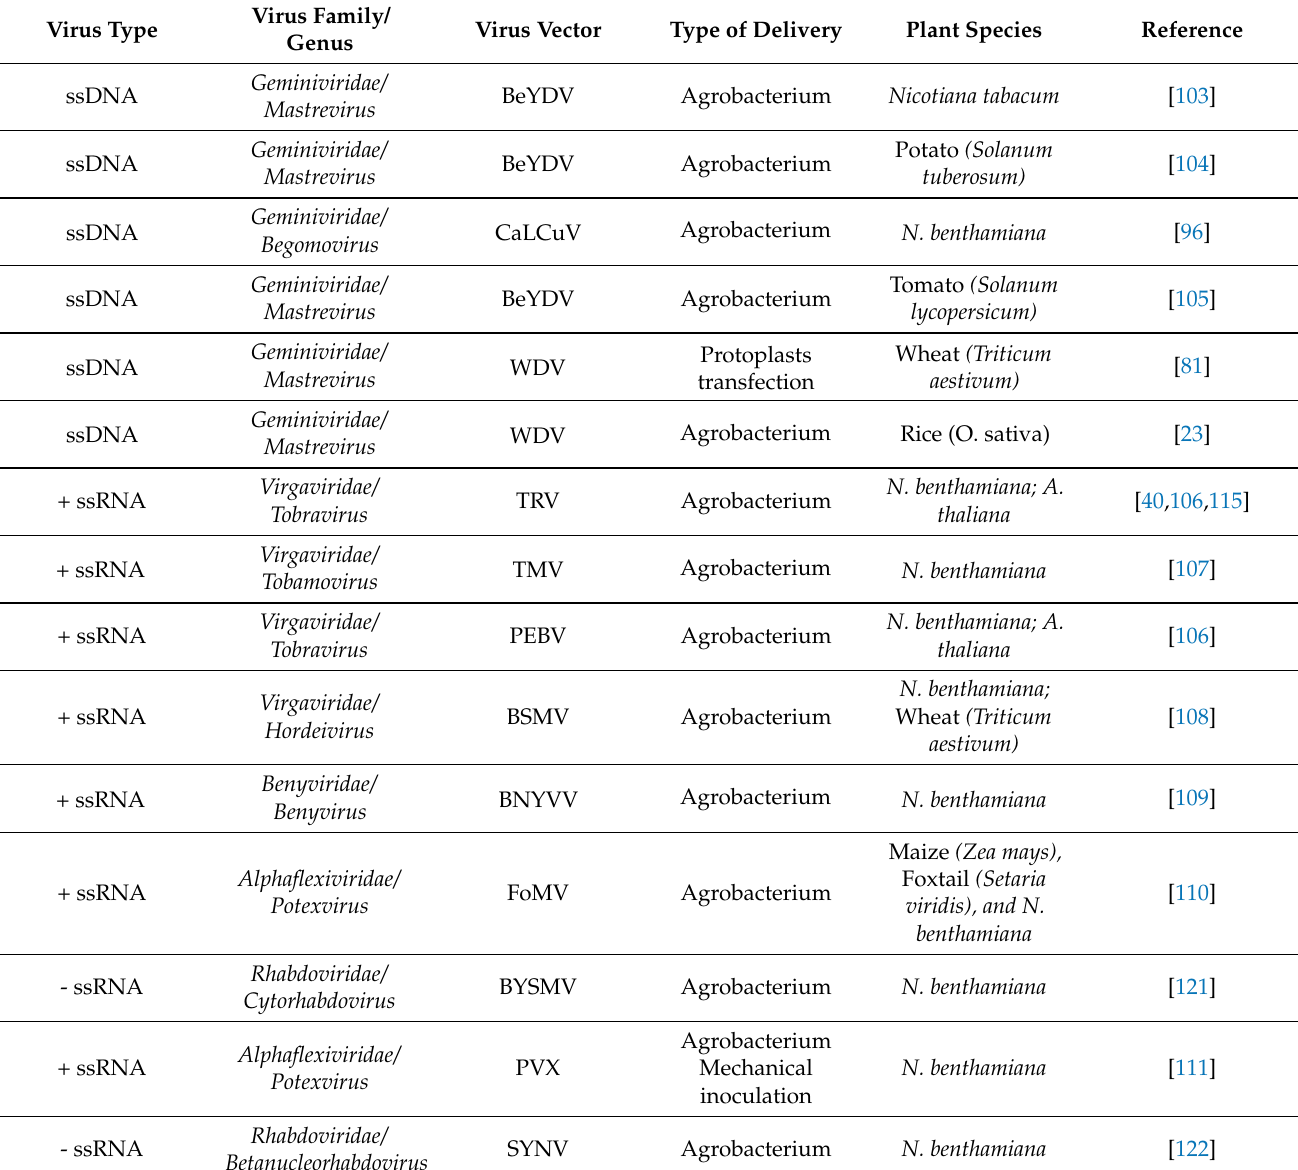
Table 2. Viruses used to carry CRISPR sequences into plants and type of